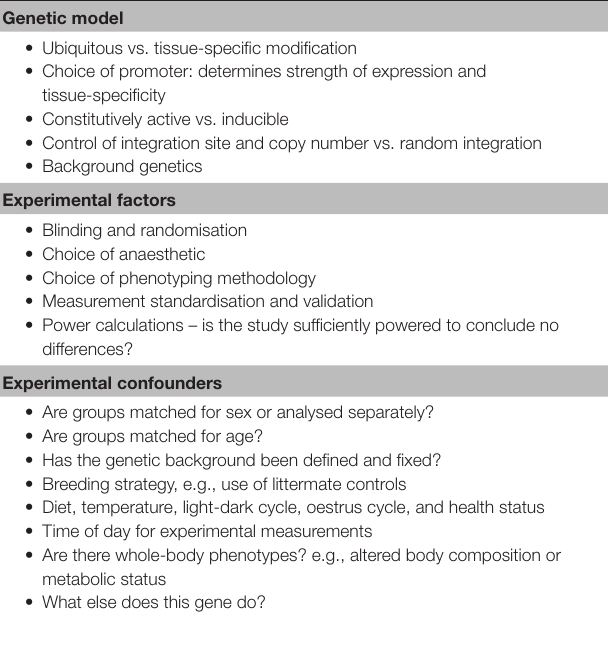
TABLE 1 | Checklist for planning or evaluating murine in vivo